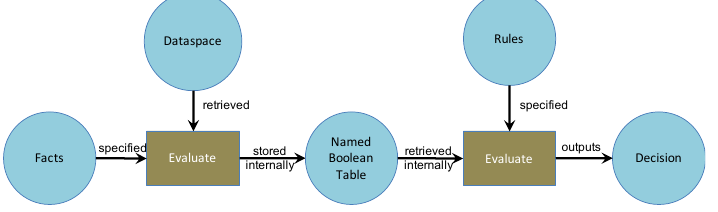
Fig. 4. Logic engine: Evaluation of facts and